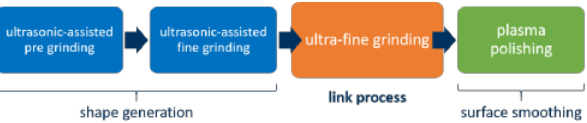
Fig. 1. Schematic representation of novel process chain for freeform